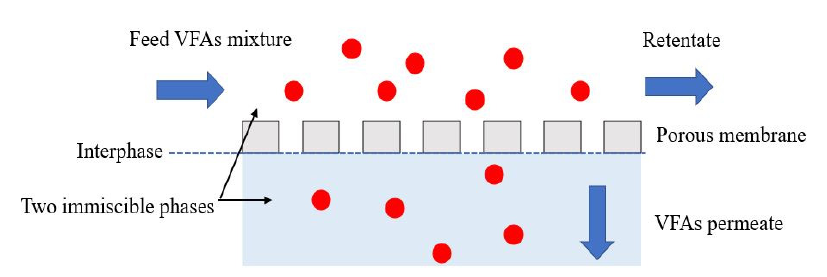
Figure 2. Operating principle of VFA recovery by membrane contactor.